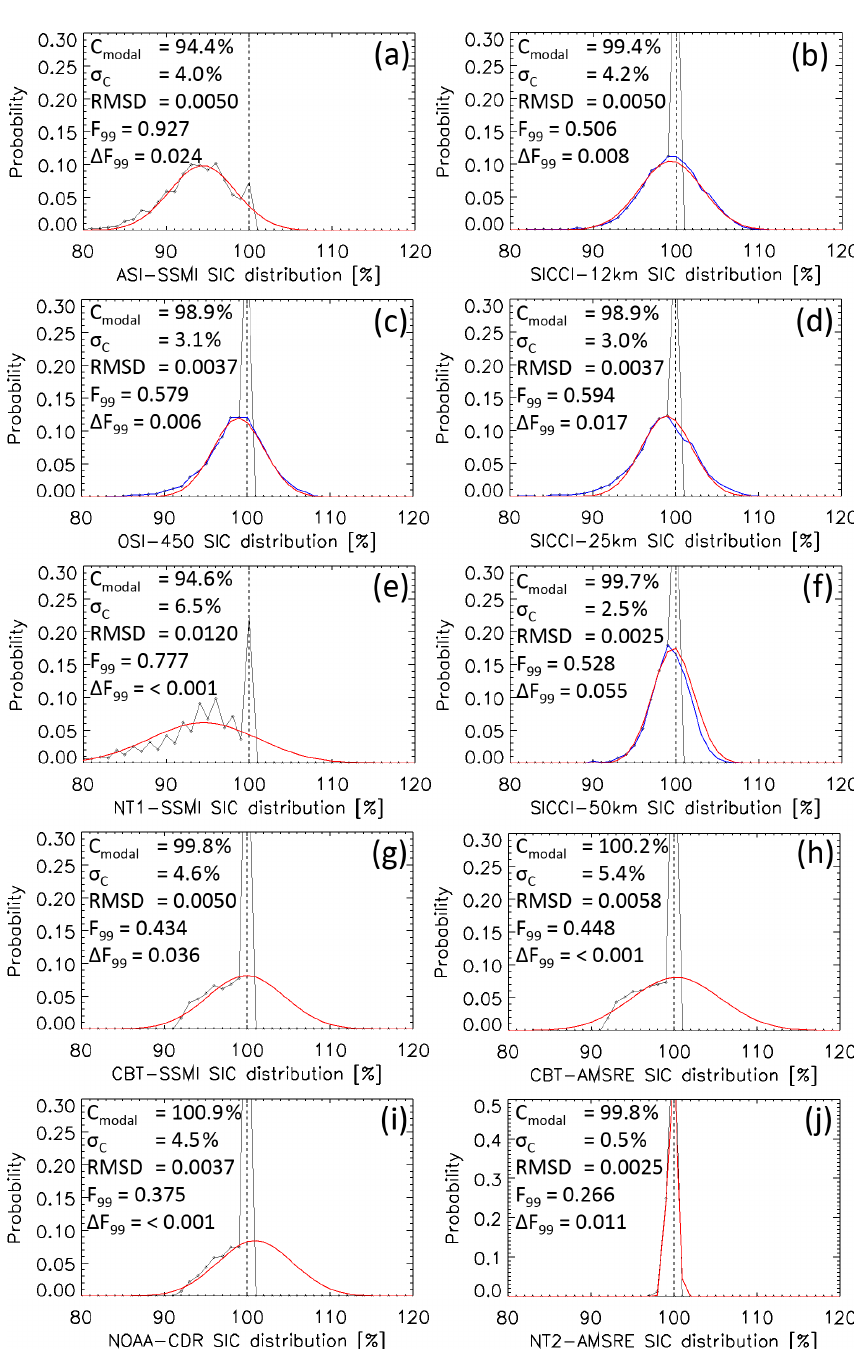
The Cryosphere, 13, 3261–3307, 2019